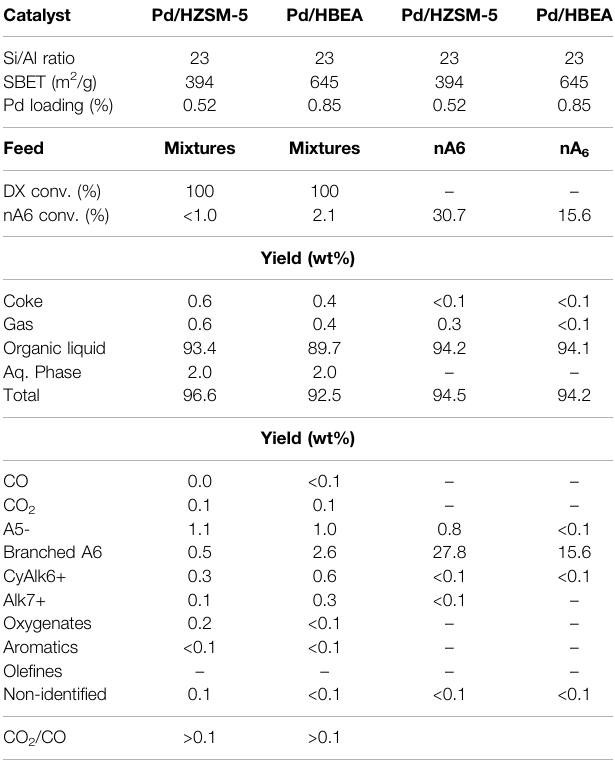
TABLE6| ComparisonbetweenPd/HZSM-5andPd/HBEAcatalystsonDXHDO product distribution and yield (wt%). Conditions: 250 ° C; 30 bar of H 2 ; 90 g n-hexane; 5 g DX; 10 g Cat; catalyst/DX (cid:1) 2/1; reaction time (cid:1) 4 h.